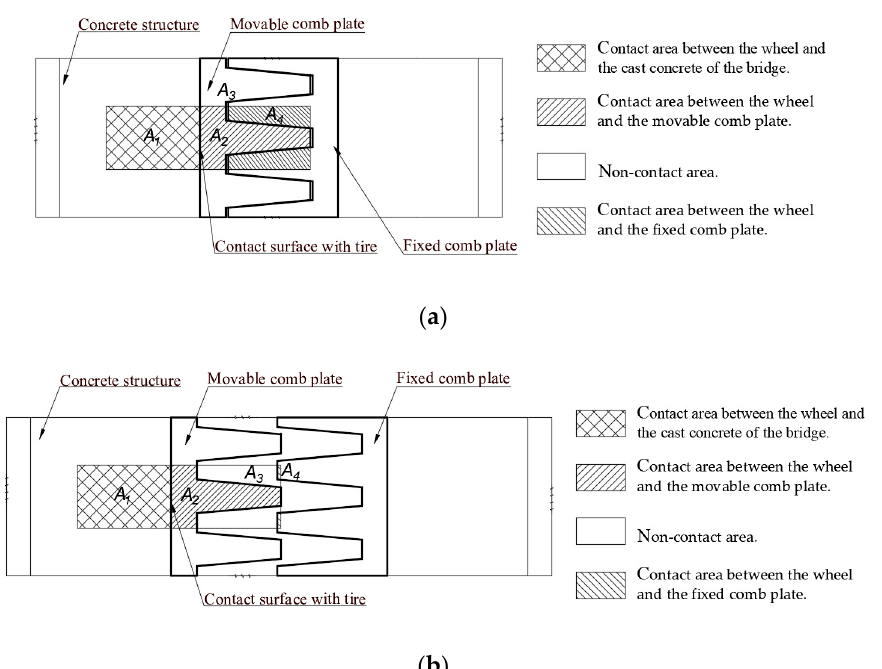
Figure 2. The contact area under the two working conditions: ( a )The working condition I, ( b ) The working condition II.